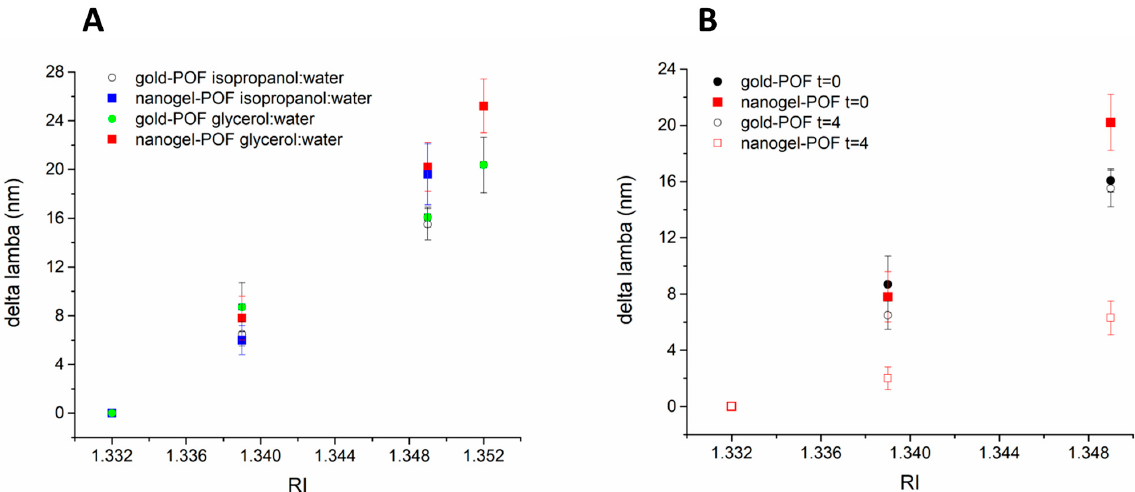
Figure 4. ( A ) The shift of the plasmonic minimum ( ∆ λ ) is plotted as a function of the refractive index (RI) of the surrounding environment at the initial sample-dropping time (t = 0) for the bare gold POF and nanogel–POFs. For all reported conditions, the ∆ λ linearly correlated to the RI. ( B ) The ∆ λ is plotted as a function of the RI of the surrounding environment (water and water:isopropanol mixes) both at the initial sample-dropping time (t = 0) and after 4 min (t = 4) for both bare gold POF and nanogel–POFs. The comparison between incubation times t = 0 and t = 4 min shows that the bare gold POF has an optical response uniquely related to the RI of the surrounding environment. In contrast, for the nanogel–POF, the isopropanol:water mixes that have a documented shrinking effect on the nanogels [27] produced a significant drop in the optical responses (t = 0 red solid squares; t = 4 red open squares). The result highlights optical effects associated with the softness of the nanogels on the probe, hence the possibility to sense the different environments by exploiting soft non-specific materials and monitoring their over-time deformations.